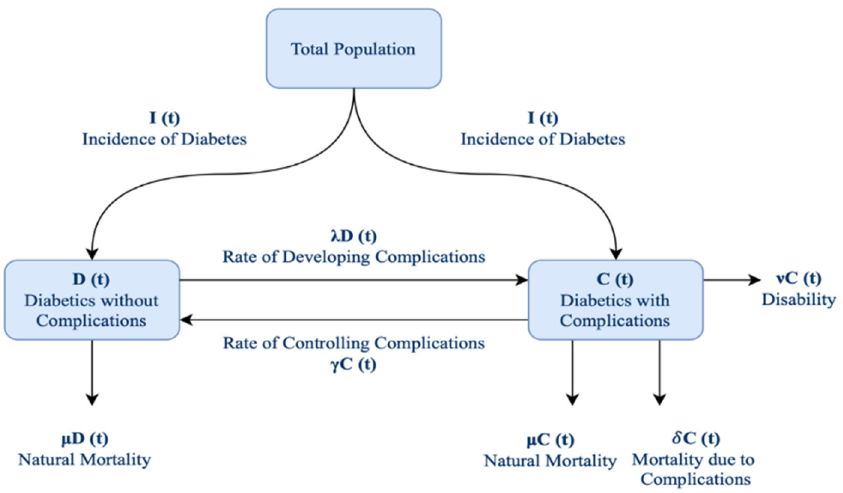
Figure 1. The DC model.